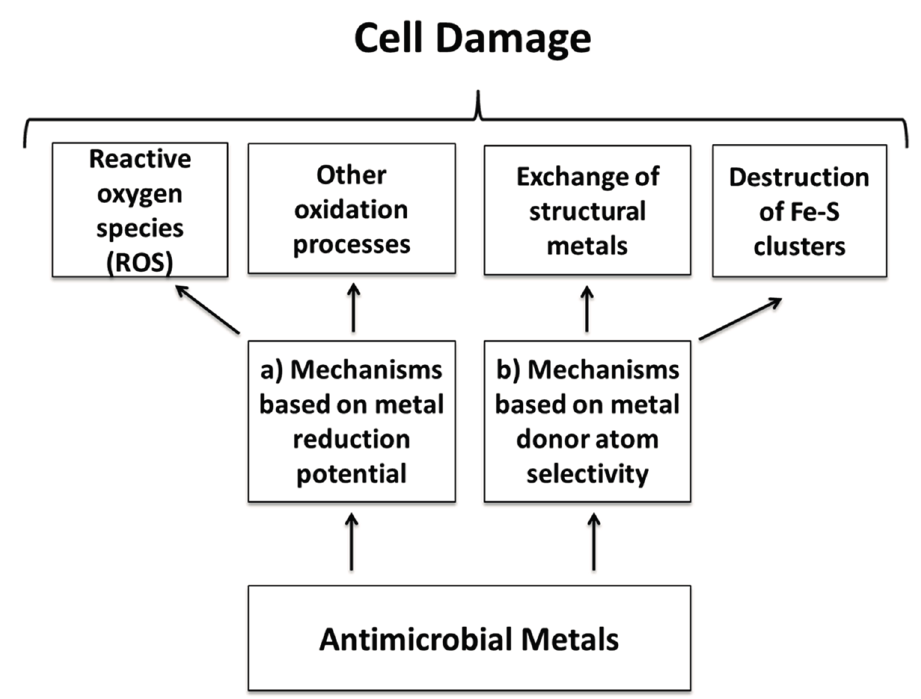
Figure 1. A summary of the main mechanisms behind the antimicrobial behavior